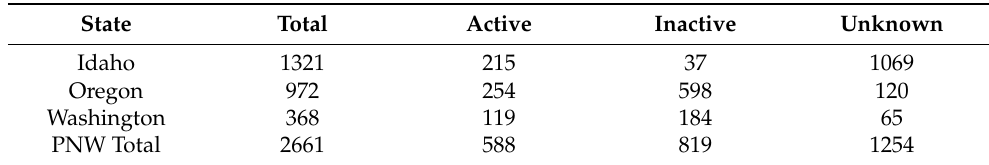
Figure 4. Streamflow monitoring location status (active, inactive, or unknown) for each continuous monitoring location in each state. Table 2. Status of continuous monitoring locations recorded in the Streamflow Data Catalog in each state.